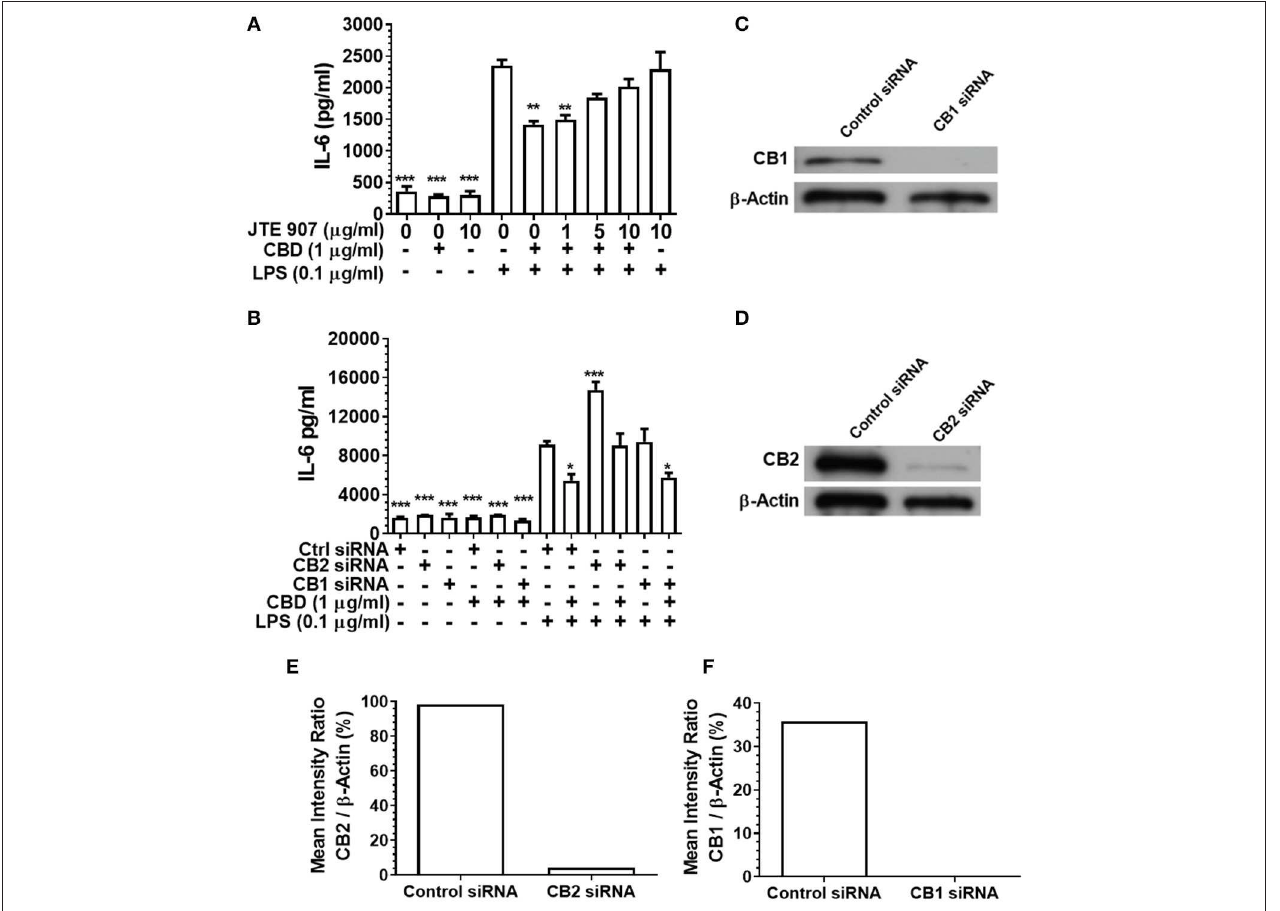
FIGURE 4 | Inhibition or silencing of CB2 abrogates CBD-mediated innate suppression. IL-6 concentrations in 20h cell-free supernatants were collected from primary human monocytes stimulated, or not, with LPS (0.1 µ g/ml) in the presence or absence of CBD (A) with and without CB2 blockade by JTE907 or (B) with or without CB1 or CB2 silencing using siRNA. Efficient knockdown of (C,E) CB1 and (D,F) CB2 was confirmed using Image J software. (A,B) Data represent the mean ± SD of three biological replicates. (C–F) Representative data are presented. * / ** / *** p ≤ 0.05/0.01/0.001, compared to (A) LPS-stimulated control or (B) control siRNA, LPS-stimulated